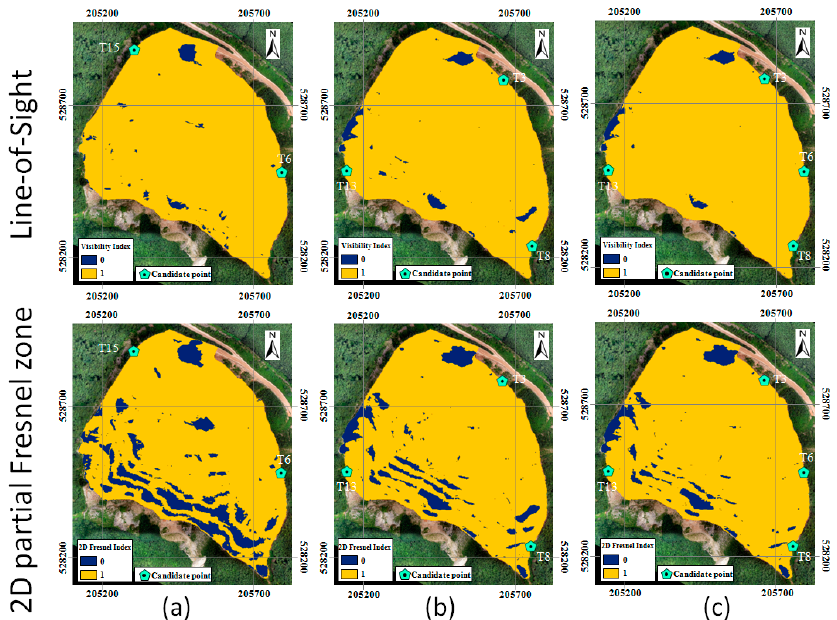
Figure 12. Visibility and 2D Fresnel index overlay maps generated from existing algorithms based on LOS and 2D partial Fresnel zone analyses: ( a ) combination of T6 and T15, ( b ) combination of T3, T8, and T13, and ( c ) combination of T3, T6, T8, and T13.